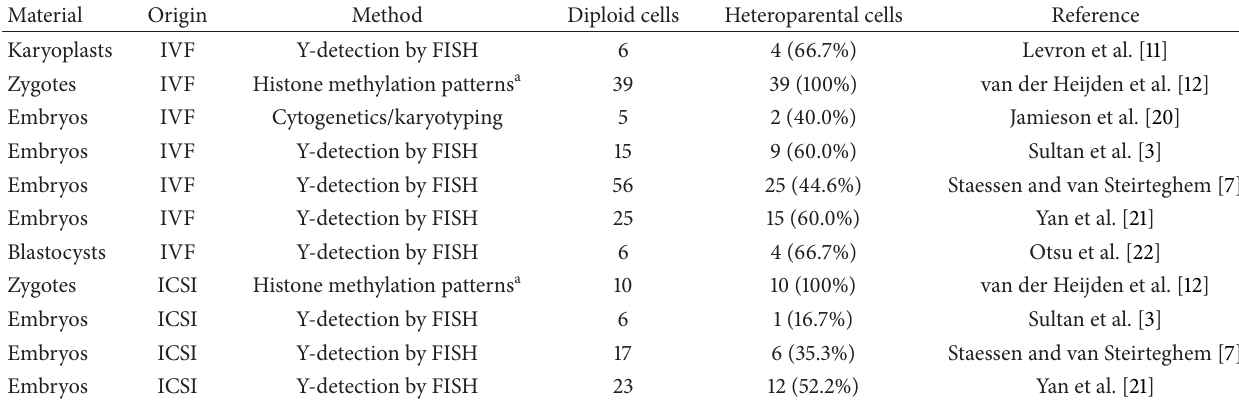
Table 3: The origin of diploidy in monopronuclear oocytes and ensuing developmental